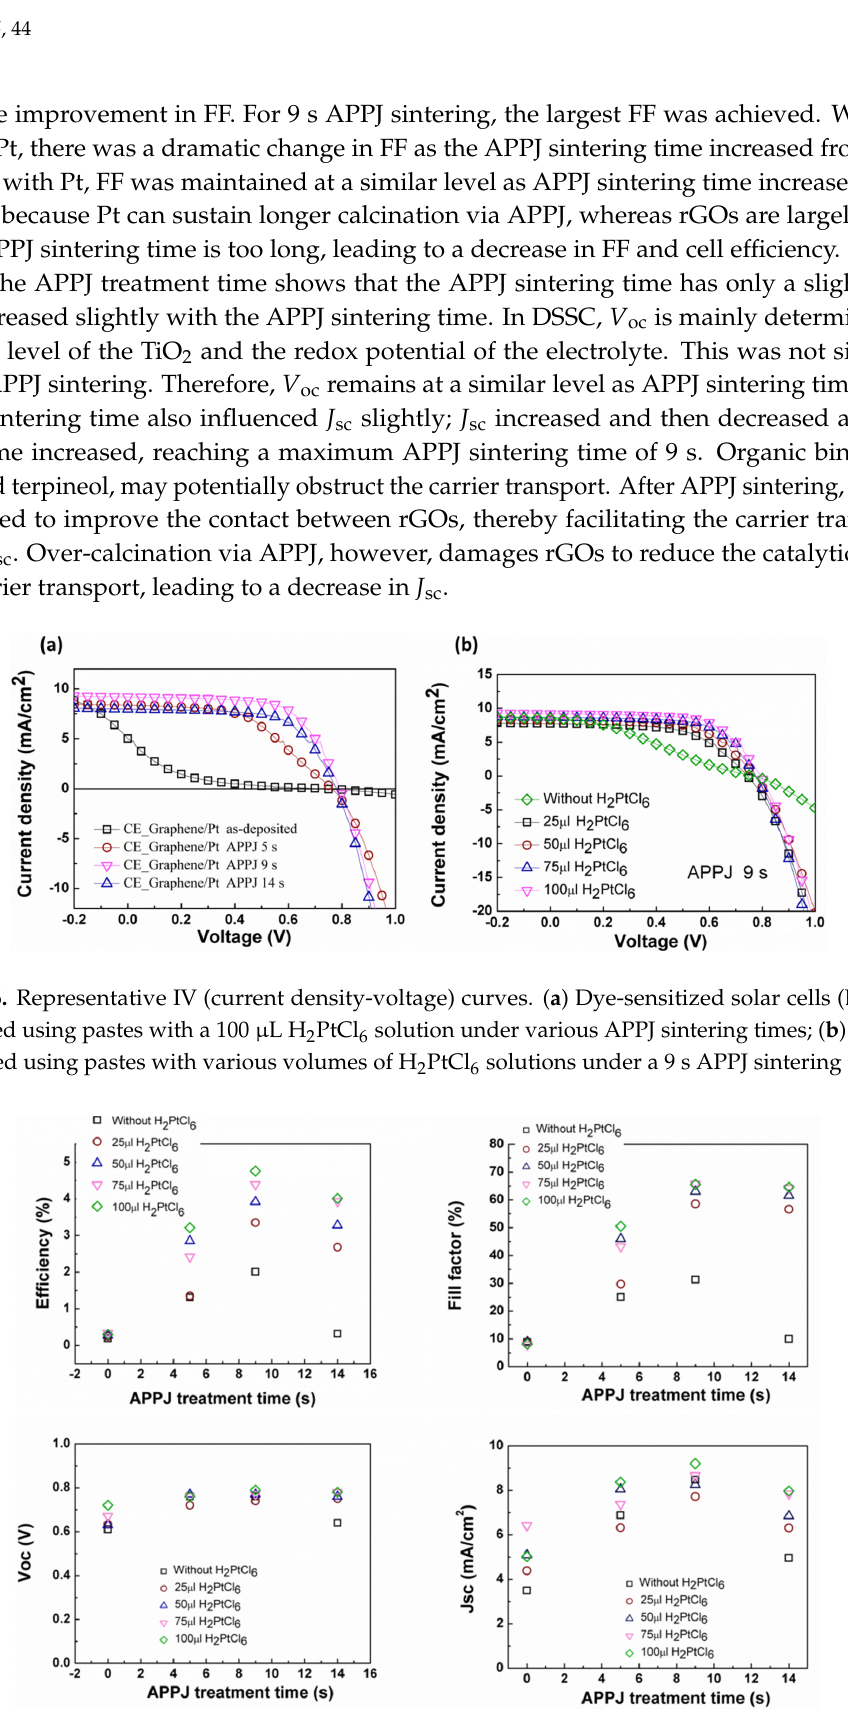
Figure 7. DSSC parameters (efficiency, fill factor (FF), open circuit voltage ( V oc ), and short circuit current ( J sc ) plotted against the APPJ treatment time.